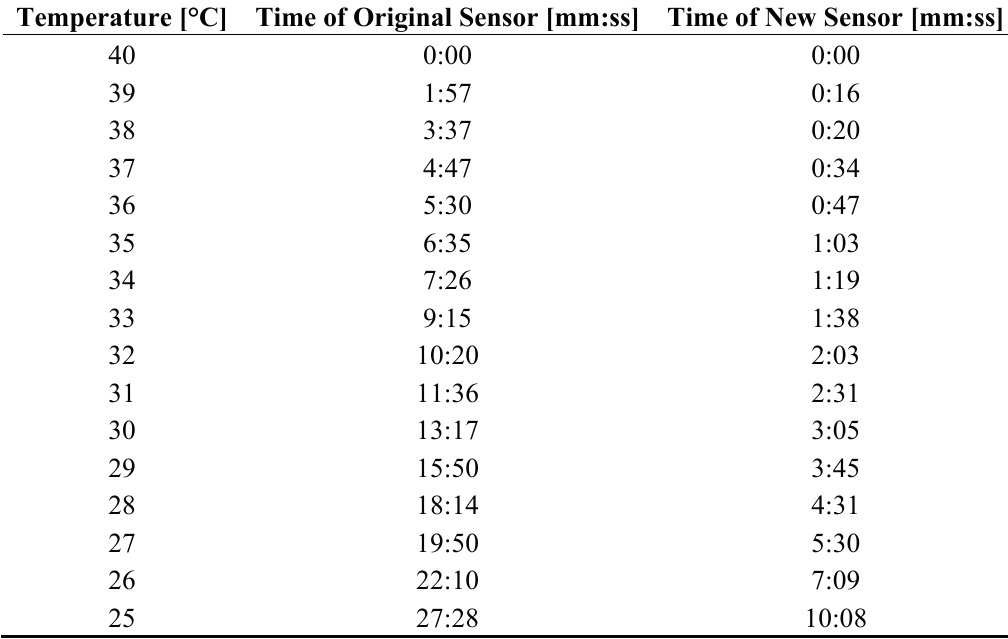
Table 6. Time delay of the sensors when the temperature is